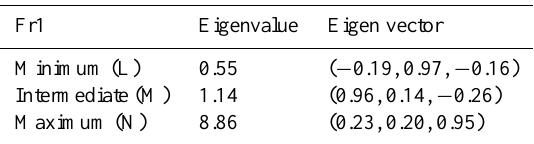
Table 1. Results from MVA applied to C2 magnetic field between 10:06:54 and